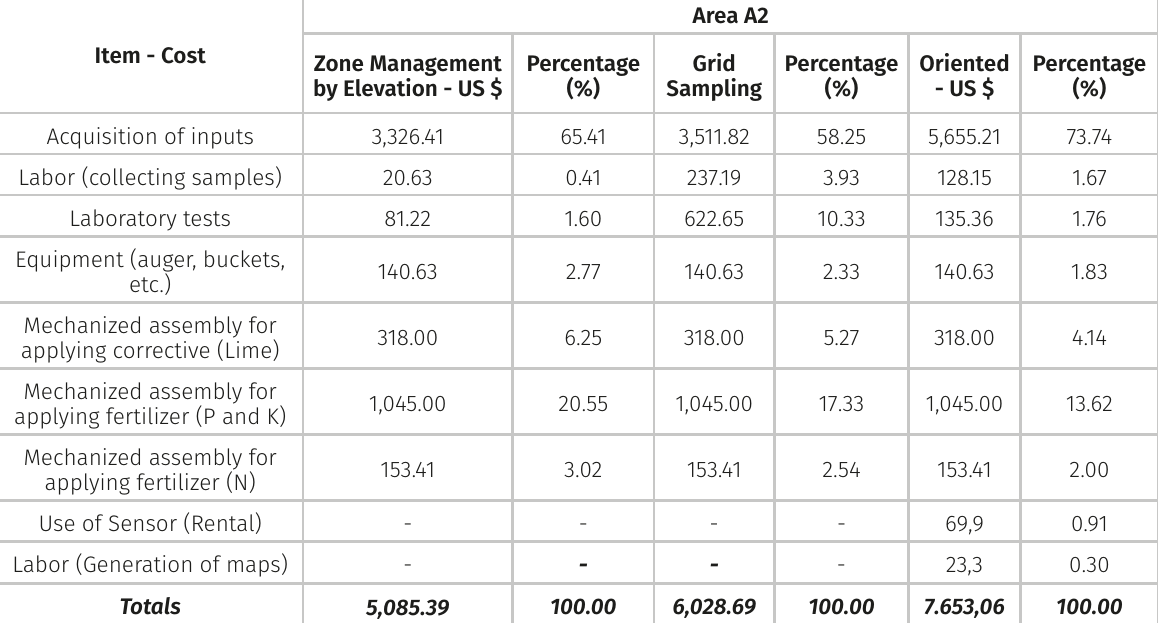
Table VI. Acquisition costs of raw materials, labor, laboratory analysis, equipment, machinery, sensor use and generation of maps for area A2.